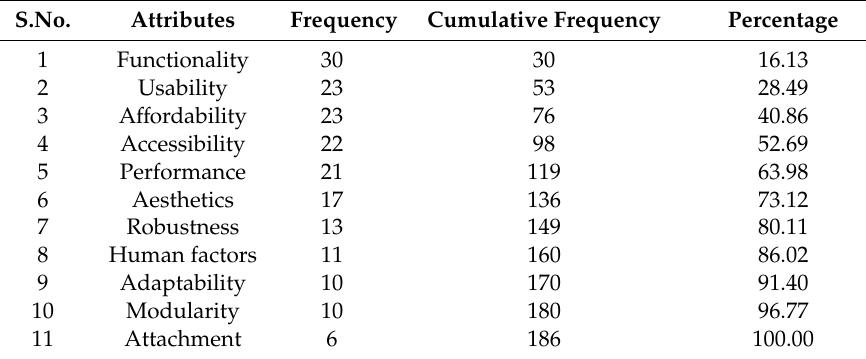
Table 2. Cumulative frequency distribution for predicting vital attributes.